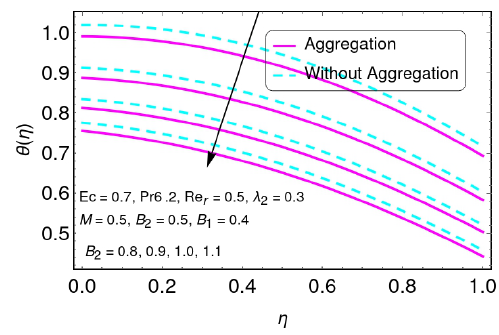
Figure 20. Characteristics of B 2 for θ ( η ) .